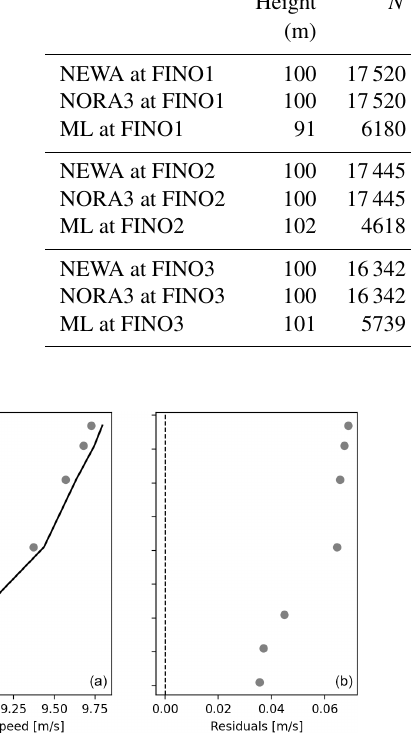
Figure 3. (a) 2010–2021 mean wind profile at FINO3 from the RFM as a line and the corresponding measurements as